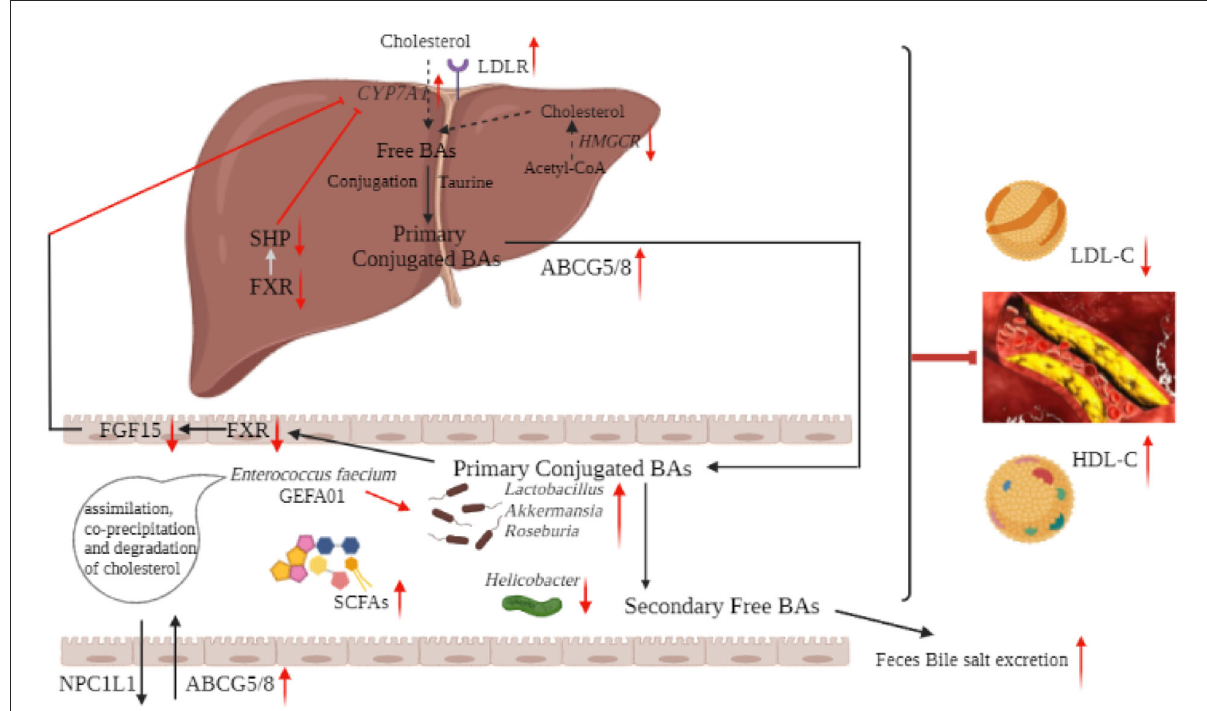
FIGURE9 Schematic diagram of the mechanism of hypocholesterolemic effect of E. faecium GEFA01. Red arrows indicate an increase or decrease of expression, and light blue arrows indicate a